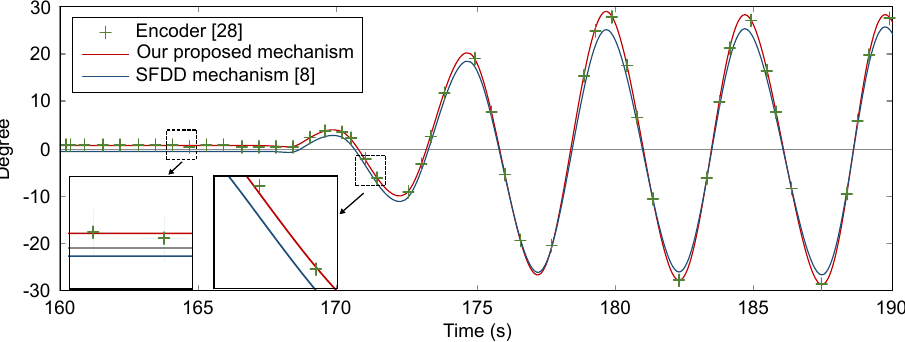
Figure 6. The comparison of calculated orientations among the true value, our proposed mechanism, and the sensor fusion device driver (SFDD) mechanism.